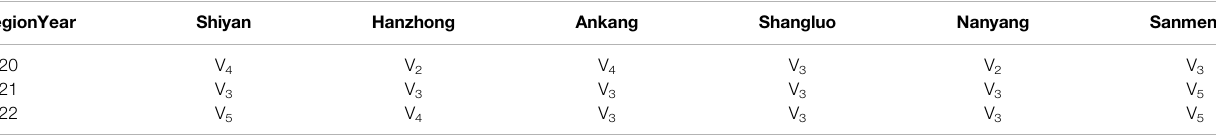
TABLE 3 | Water resources value of regions in water source area in 2020 – 2022.